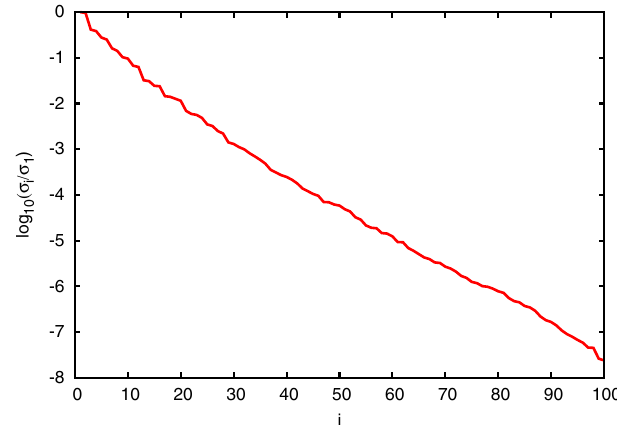
=(cid:3) ) of the seed matrix i 1